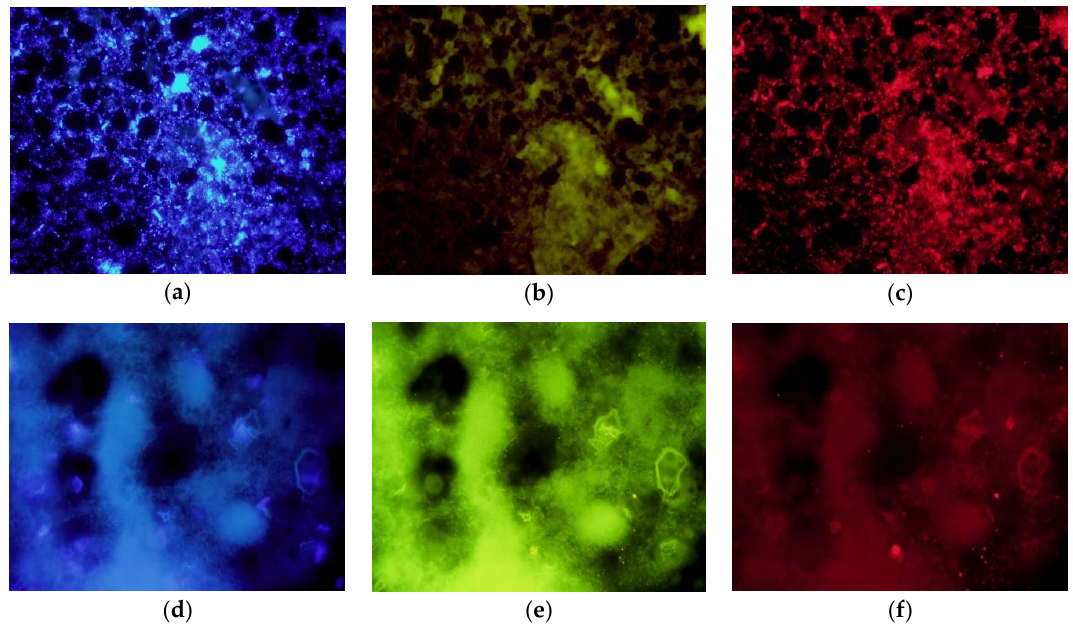
Figure 4. Fluorescence in situ hybridization of dark and white uropygial secretions. Fluorescence microphotographs of the dark uropygial secretion of a hoopoe breeding female ( a – c ), and a white secretion of a female in winter ( d – f ) hybridized with the universal probe Eub338 marked with Cy3 to stain bacterial RNA, and with Hoechst to stain DNA. The three images in each line are of the same microscope field, but are taken with the DAPI (blue), fluorescein-5-isothiocyanate (FITC, green-yellow), and tetramethylrhodamine-isothiocyanate (TRITC, red) filters. In the first sample, bacteria are stained in blue ( a ) and red ( c ). The images taken with the green FITC filter are included to show that a fine grain texture usually found in white secretions (example in d – f ) does not correspond to stained nucleic acids because they show the same aspect in the three filters.